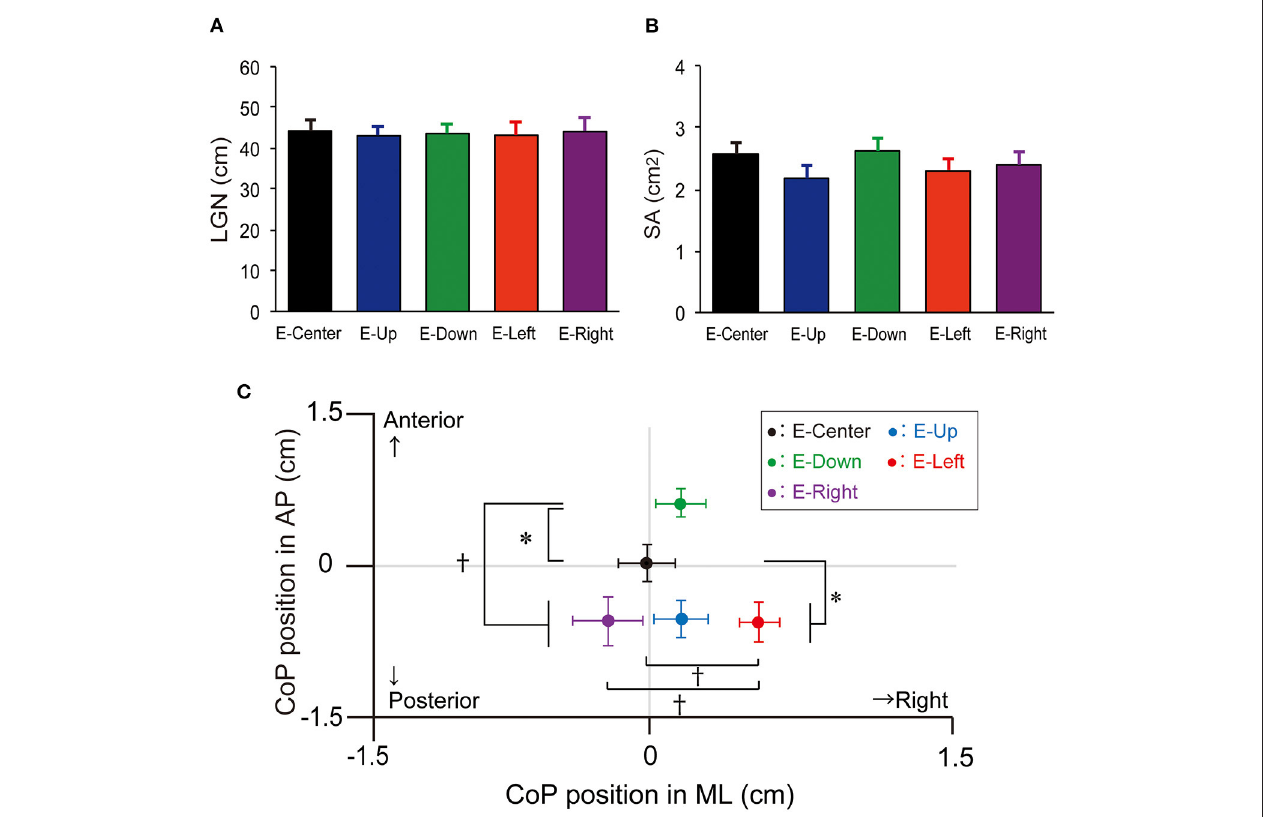
FIGURE 2 | LNG, SA, and mean position of the CoP. (A) LNG and (B) SA with the E-Up, E-Down, E-Right, E-Right, and E-Center eye positions. The vertical bars reflect the mean LNG and SA. The error bars indicate the standard error of the mean. (C) The mean CoP position in the ML and AP directions. The solid circles indicate the mean CoP position. The error bars indicate the standard error of the mean. * p < 0.05, † p < 0.01. LNG, total trajectory length; SA, sway area; CoP, center of pressure; ML, mediolateral; AP,